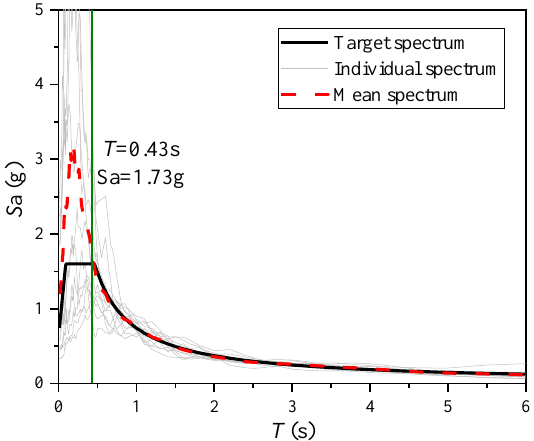
Figure 16. Response spectra of the earthquake records scaled to DBE level. Figure 17 shows the story-wise distribution of the inter-story drift ratio (ISDR) of the prototype and enhanced SMRF. The maximum mean ISDRs of the prototype were 0.50%, 1.64% and 2.30% for SLE, DBE and MCE levels, respectively, which are larger than the design targets of 0.4%, 1.5% and 2.0%, indicating that the design requirements were not met, and the seismic performance needs to be enhanced. After being enhanced, the maxi- mum mean ISDRs were, respectively, reduced to 0.38%, 1.32% and 1.99%, which are ap- proximate to the design targets. Figure 18 compares the roof drift ratios between the ana- lytical values and the targets. The mean roof drift ratios for SLE, DBE and MCE levels were, respectively, 0.25%, 0.89% and 1.31%. The errors between these values and the tar- gets are about 0%, 5% and 5%, respectively. In general, the enhanced SMRF is not only capable of achieving the ISDR targets of multiple seismic hazard levels but also the roof drift ratio targets, demonstrating the effectiveness of the enhanced SMRF, realizing the expected seismic performance objectives and of the proposed design procedure.